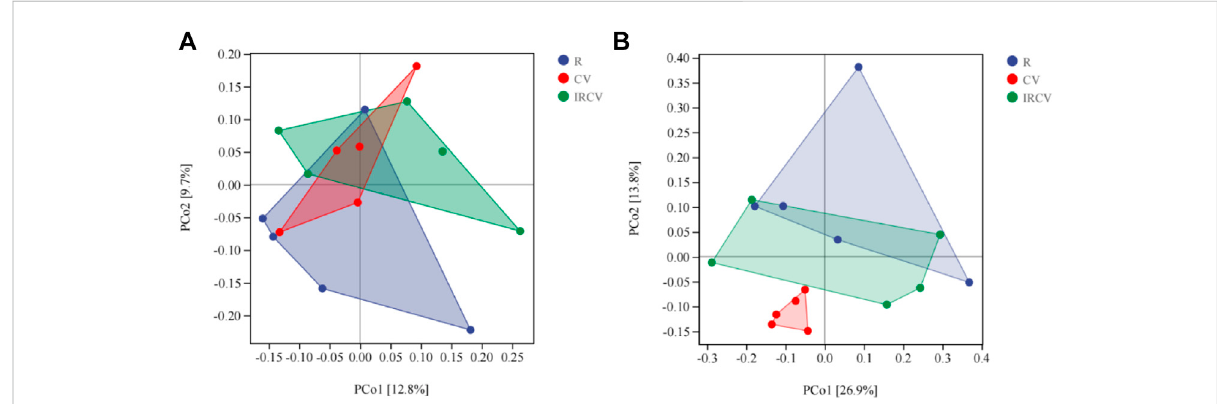
FIGURE 4 Principal coordinates analysis (PCoA) representation of soil bacterial (A) and fungal communities (B) in the three cropping sequences (OTUs with relative abundance of more than 0.01%). CV, R, and IRCV represent common vetch monoculture, rape monoculture, and R and CV intercropping,